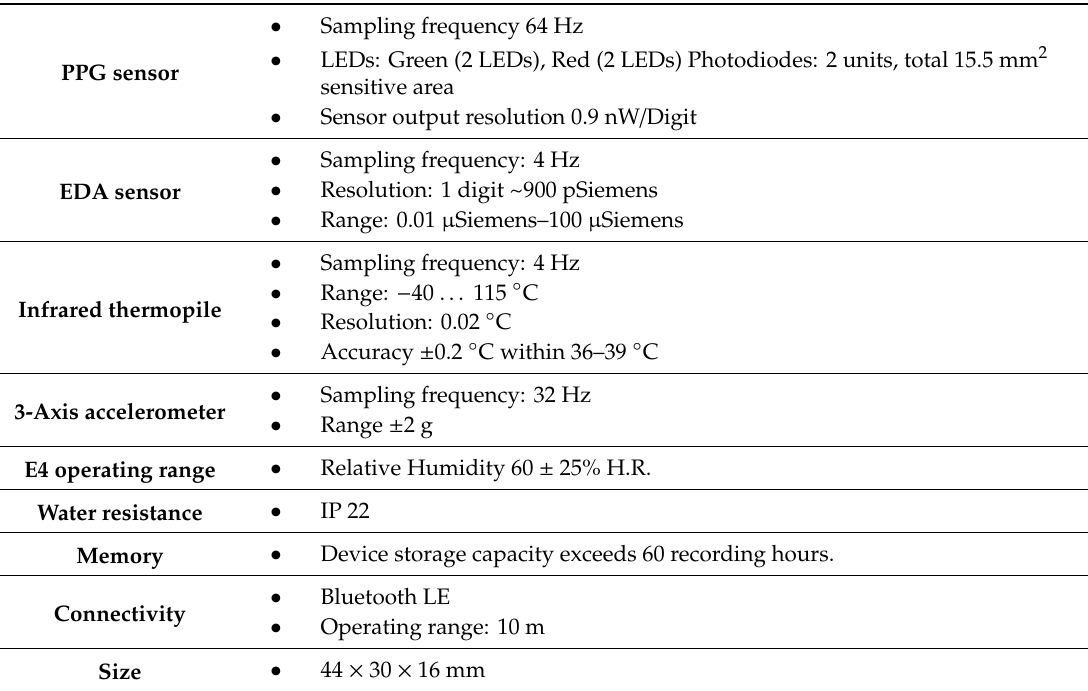
Table 2. Empatica E4 specifications. Data from